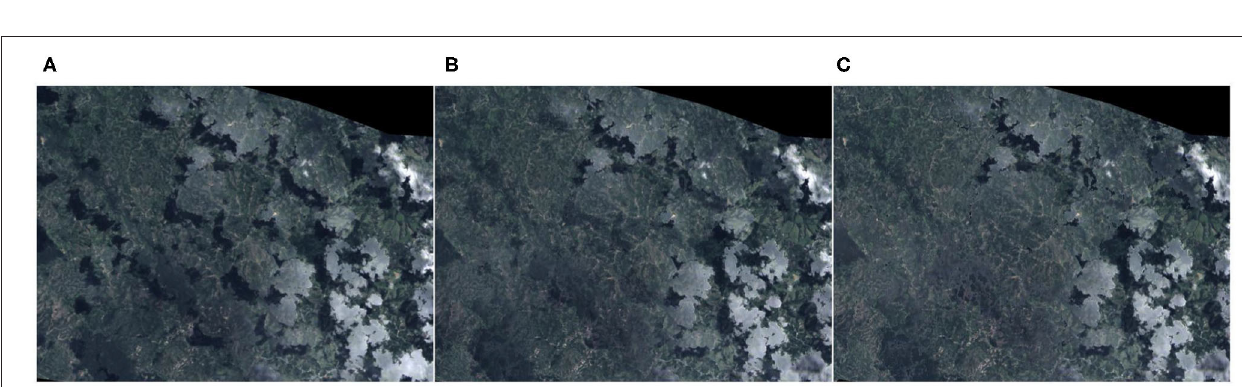
FIGURE 2 | Resulting image choosing different percentages in the composite. (A) Composite of landsat images using the pixel value in the percentile 20th. (B) Composite of landsat images using the pixel value in the percentile 50th. (C) Composite of landsat images using the pixel value in the percentile